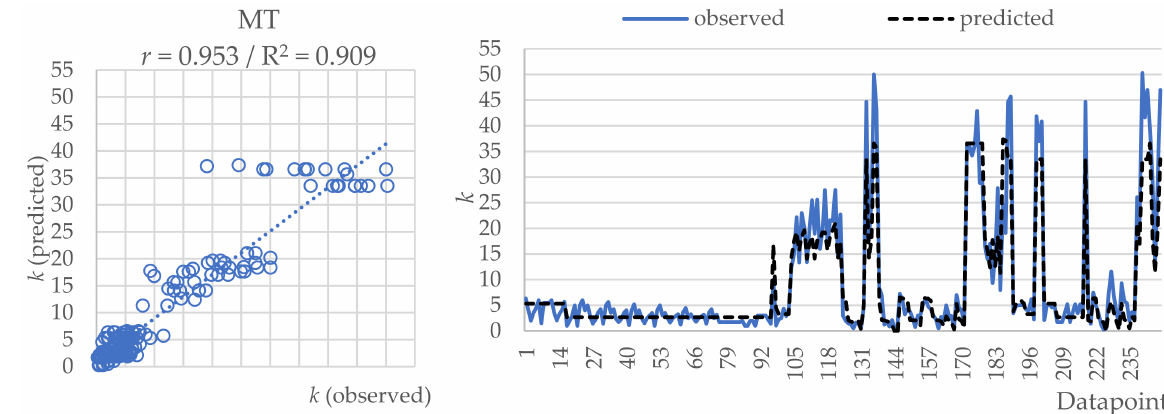
Figure 9. Scatter plot and hydrograph for MT